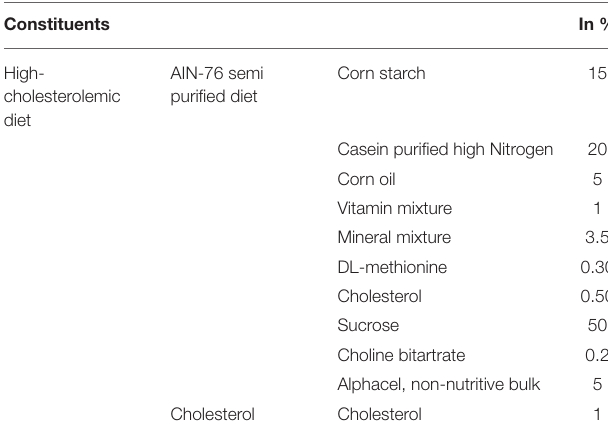
TABLE 1 | Composition of experimental high- cholesterolemic